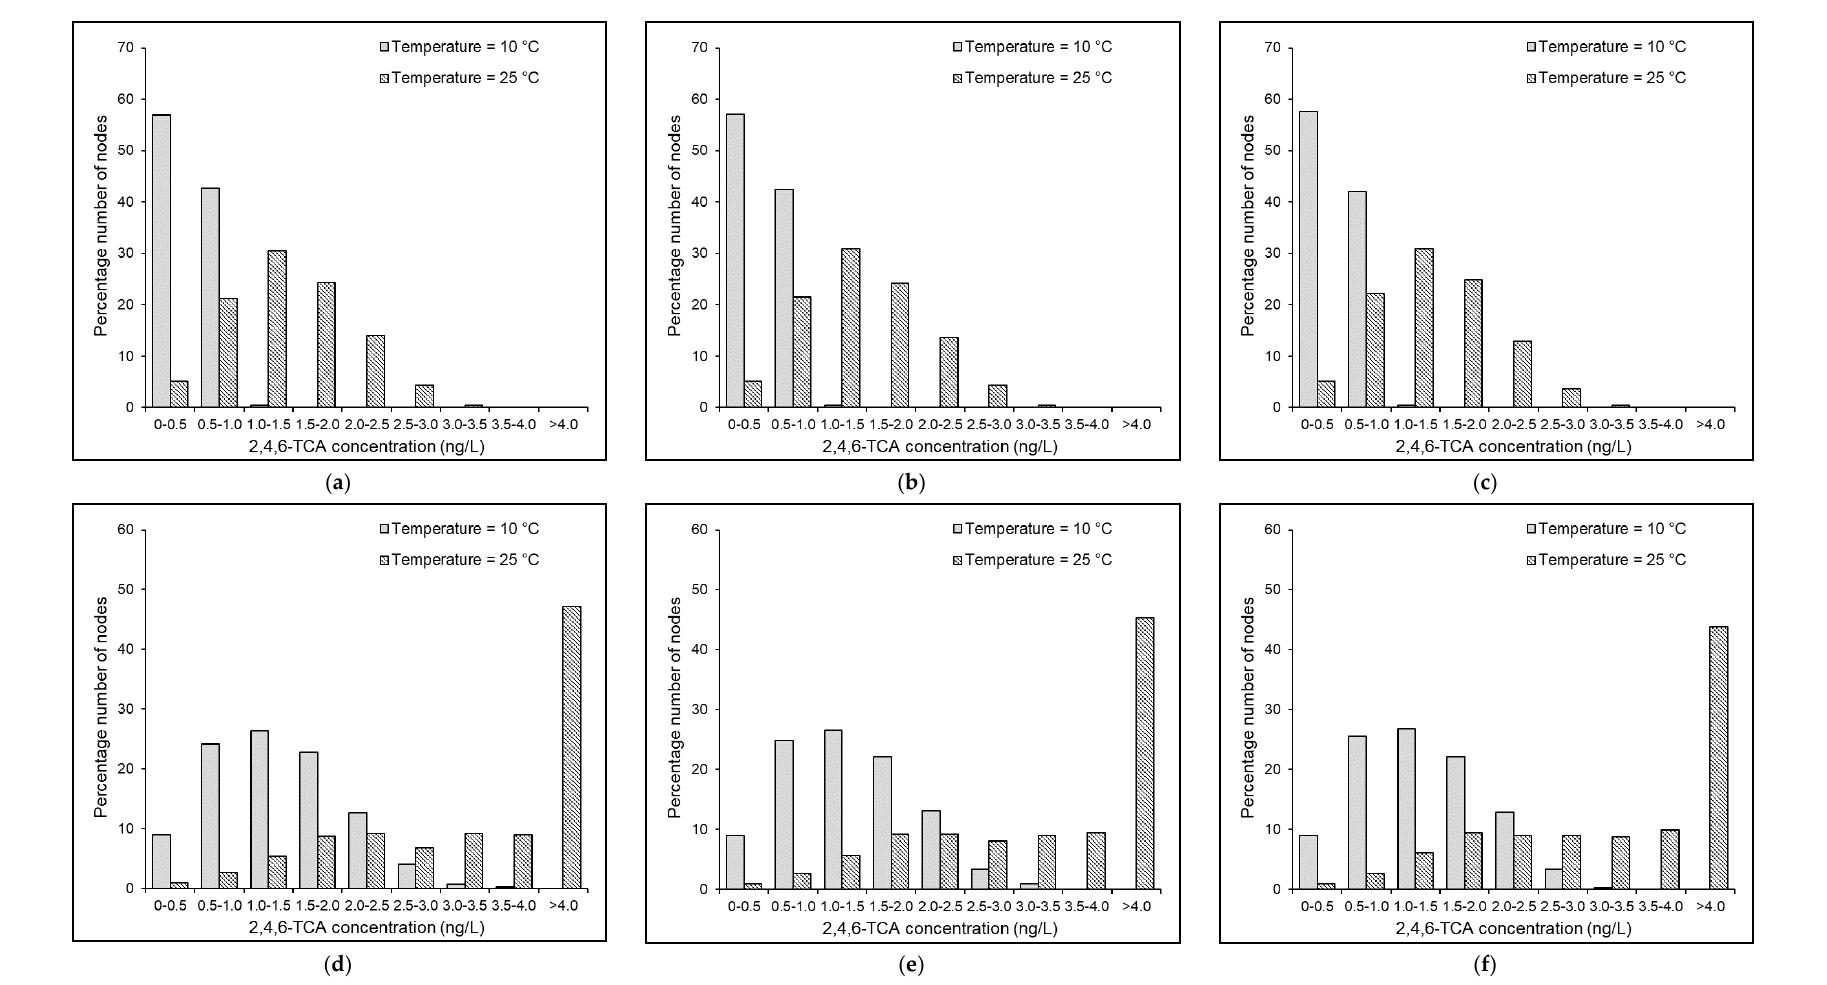
Figure 6. Predicted distribution of 2,4,6-TCA in the Balerma network under 𝑃 𝑜 = 0.2 mg/L, 𝑆 𝑜 = 0.01 mg/L, 𝐶 𝑜 = ( a , d ) 0, ( b , e ) 0.5, and ( c , f ) 1.0 mg/L, and Scenarios ( a – c ) I and ( d – f ) II.